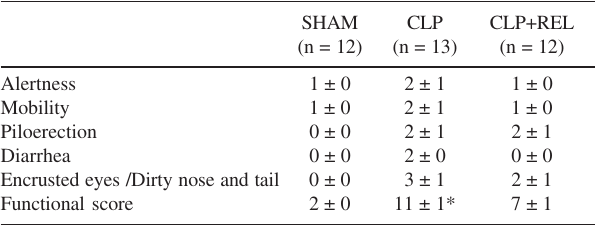
Table 1 - Functional features 24 hours after intervention SHAM CLP CLP+REL (n = 12)